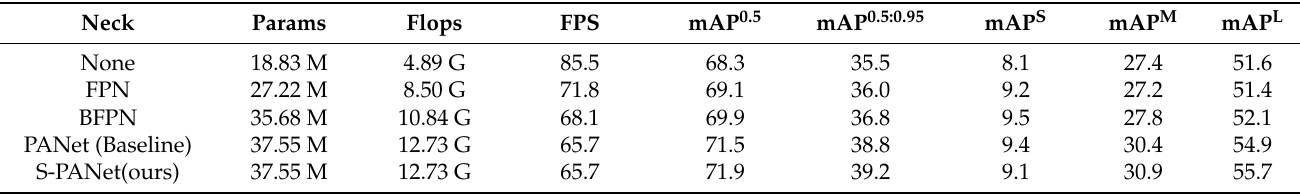
Table 7. Results of comparative experiment for different